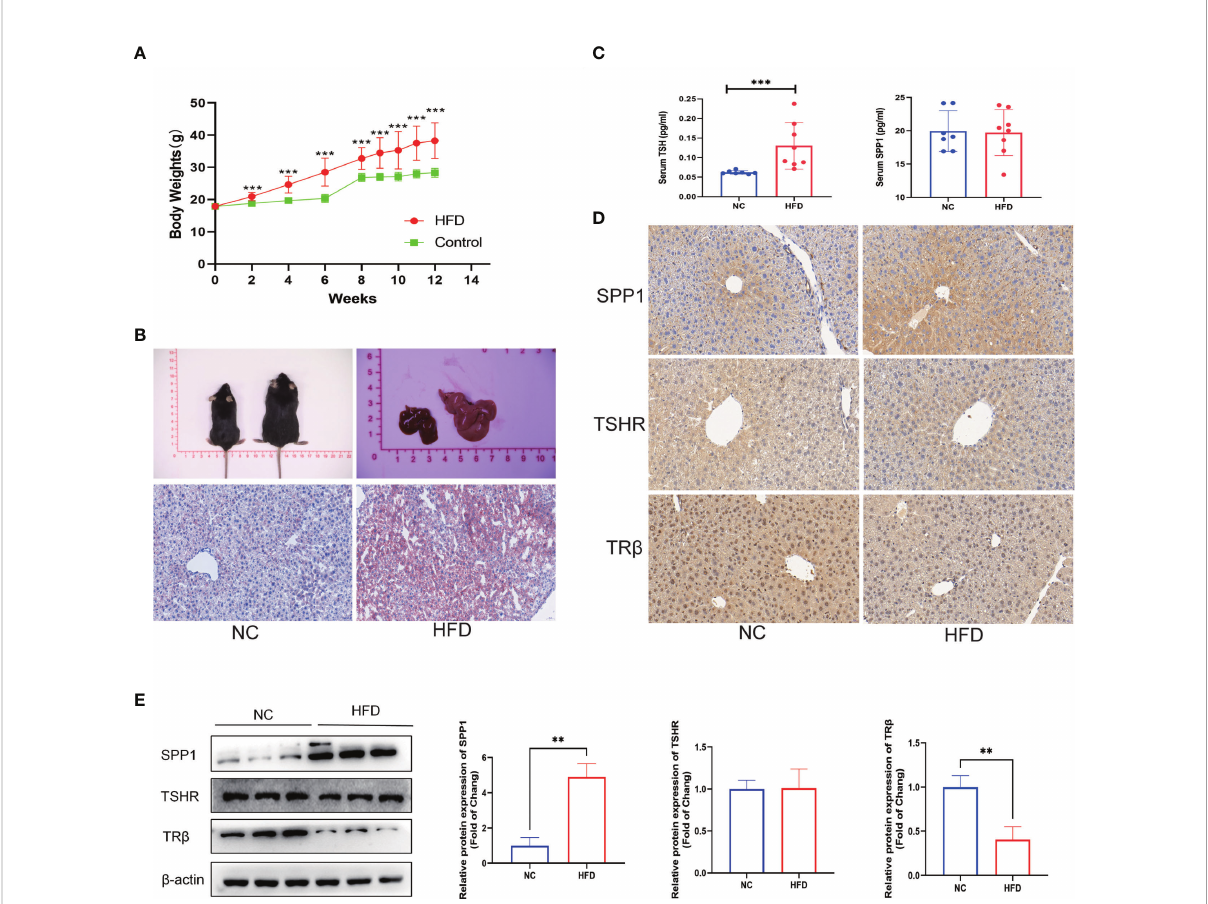
FIGURE 5 Validation of related clinical phenotypes and gene expressions in a non-alcoholic fatty liver disease (NAFLD) mice model. (A) Body weights of high-fat diet (HFD) and negative control (NC) mice over 12 weeks. (B) Representative images of the gross morphology of the liver and liver tissue sections stained with Oil Red O. (C) Enzyme-linked immunosprobent assay (ELISA) of serum secreted phosphoprotein 1 (SPP1) and thyroid-stimulating hormone (TSH). (D) Immunohistochemistry (IHC) staining of SPP1, TSH receptor (TSHR), and TR b in mice livers. (E) Quanti fi cation of the average band densities calculated from western blots of SPP1, TSHR, and TR b in the liver tissues from HFD and NC mice. Values are the mean ± SD. n = 8 mice in each the HFD and NC groups. **p < 0.01, ***p < 0.001 vs.